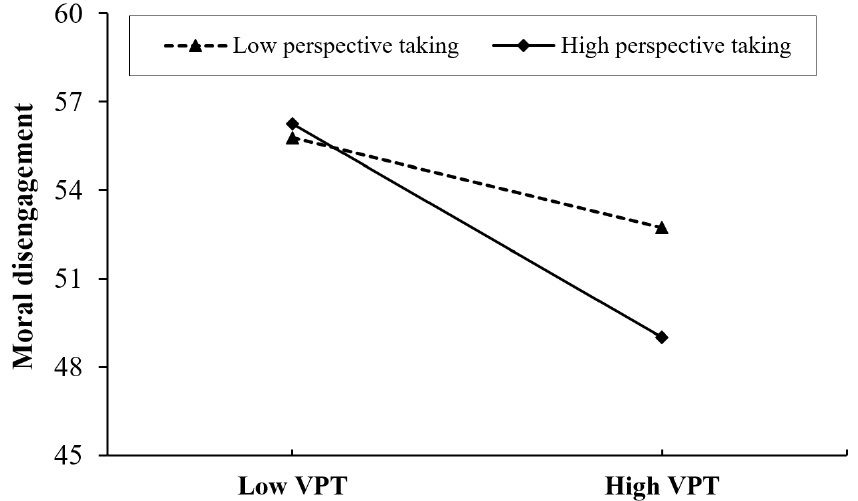
Figure 2 . Simple slopes analysis of PT as a moderator in the association between VPT and MD.